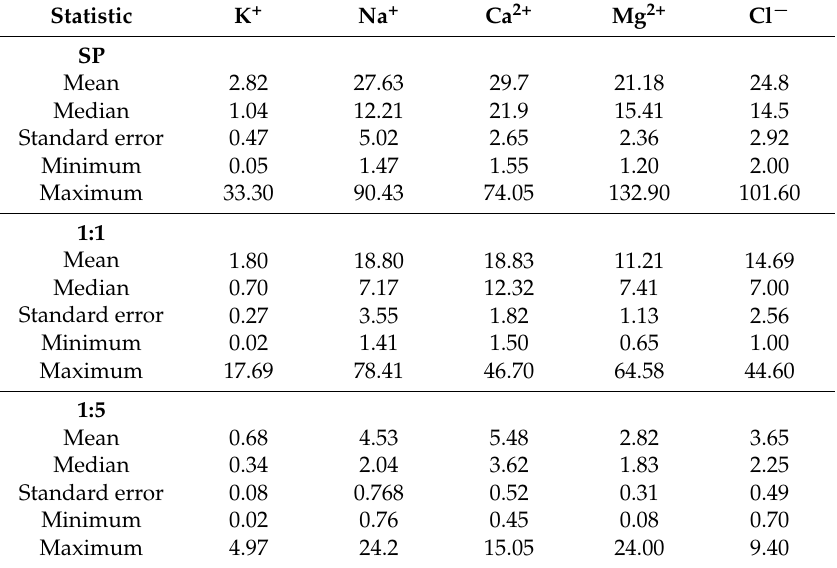
Table 3. Statistical indices for the values of ion concentrations in the extracts of SP, and 1:1 and 1:5 soil/water ratios methods (meq L − 1 ) (N = 123).